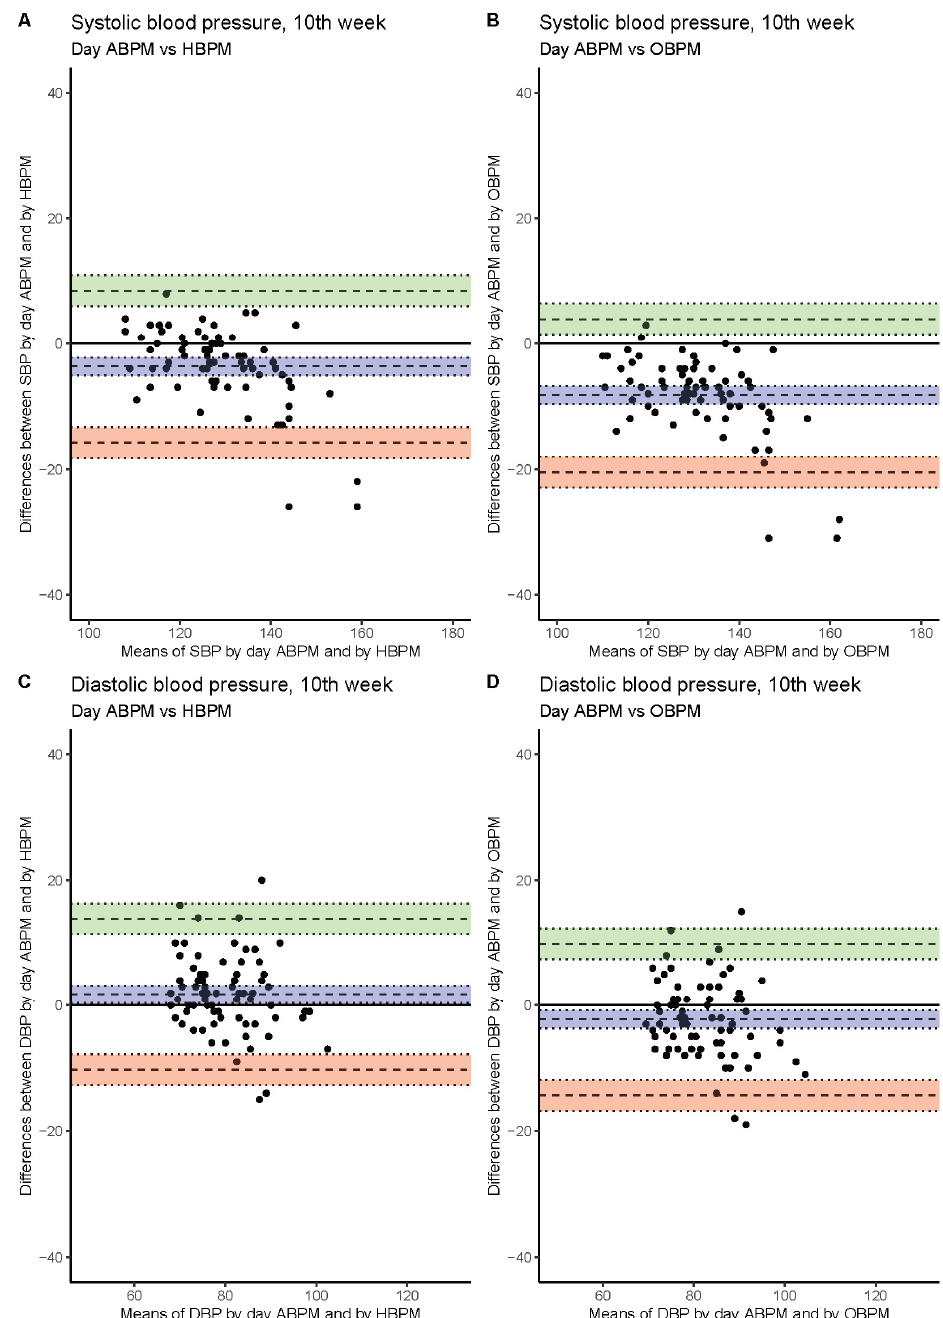
Figure 1. The agreement between systolic blood pressure values obtained by day ABPM vs. HBPM ( A ) and day ABPM vs. OBPM ( B ). Diastolic blood pressure measured by day ABPM vs. HBPM ( C ) and day ABPM vs. OBPM ( D ) in 10th week of gestation. For each patient difference and mean of blood pressure values obtained by two methods was calculated and plotted (black dots). Mean of differences is presented as bias with computed 95% confidence interval (blue). Upper and lower limit of agreement with 95% confidence intervals are presented using green and pink colors,